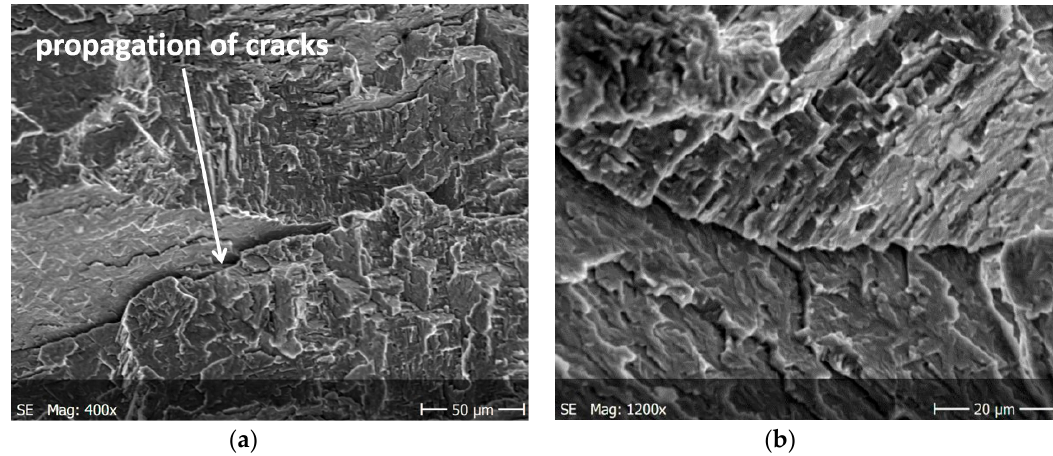
Figure 8. Cracking of O–Ti 2 AlNb alloy in specimen after static tests for ( a ) a larger specimen area, ( b ) enlarged crack.